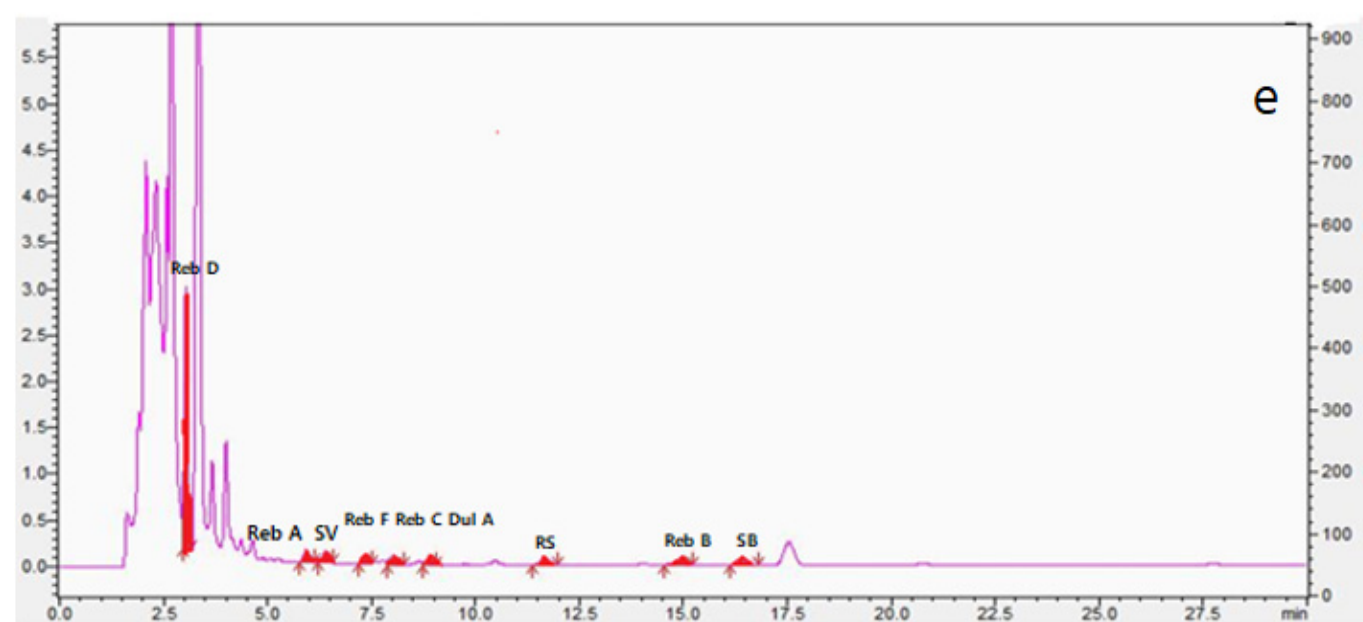
Figure 2. Chromatogram of the fermented-milk product spiked with steviol glycosides at a concentration of 500 mg/L (90–97% purity), following the various pretreatment methods. ( a ) First treatment, ( b ) second treatment, ( c ) third treatment, ( d ) fourth treatment, and ( e ) fifth treatment. Rebaudioside D (Reb D), rebaudioside A (Reb A), stevioside (SV), rebaudioside F (Reb F), rebaudioside C (Reb C), dulcoside A (Dul A), rubusoside (RS), rebaudioside B (Reb B), and steviobioside (SB).